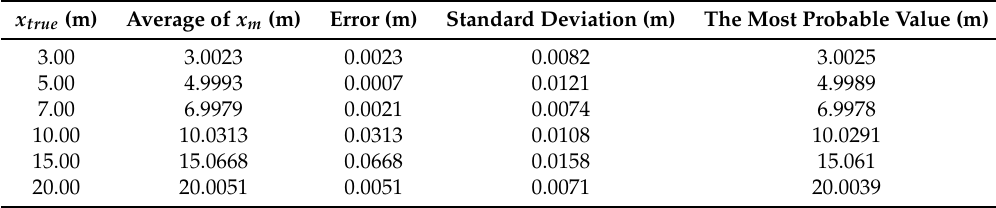
Figure 6. Fitting results from the distance between 3 m to 20 m. Corrected measurements show better linearity and are closer to the true value. Table 2. Results of experiments after